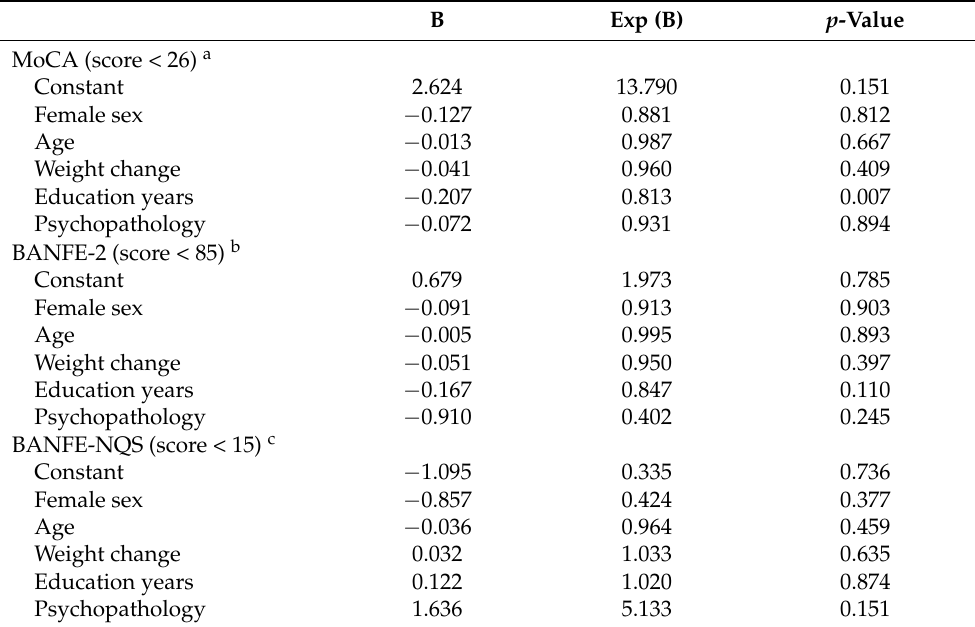
Table 5. Prediction of global cognitive performance and executive functioning at the end of a multidisciplinary weight loss program.